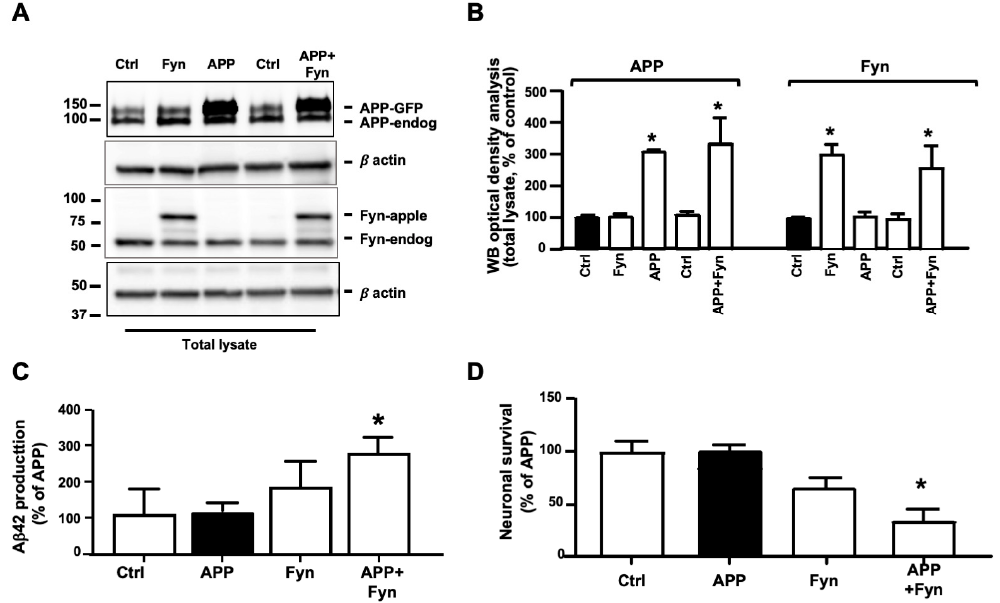
Figure 1. Amyloidogenic amyloid precursor protein (APP) processing increased in APP-GFP- and Fyn-apple-tagged neurons. ( A ) APP, Fyn, and β -actin Western blot (WB) analysis of neural stem cells after 48 h of transfection with APP-GFP (500 ng, APP) and Fyn-apple (500 ng, Fyn). A GFP empty vector was used as an internal loading control (Ctrl) or to balance the total amount of DNA for each experimental point (1 μ g DNA/well). Total lysate (20 μ g) from each sample was loaded on 4–20% Tris-Gly. The densitometric analysis of APP-GFP and Fyn-apple is reported in ( B ). Optical density values were normalized to β -actin and were expressed as a percentage of Ctrl (black bar). n = 3. * p < 0.05, vs. control using one-way ANOVA followed by Dunnett’s post hoc test. ( C ) ELISA analysis of A β 42 from media of Ctrl, APP-GFP, Fyn-apple, and APP-GFP+Fyn-apple transfected neurons. A β 42 levels were normalized to the number of alive cells (DAPI stained nuclei) that were present on each slide after 48 h of transfection and were expressed as ng of A β 42 that were released from each cell in 0.5 mL of media. Data are reported in ( C ) as % of APP transfected neurons. Each experiment was performed three times in triplicate ( n = 3). * p ≤ 0.05, vs. APP (black bar). Statistically significant differences were calculated using one-way ANOVA followed by Dunnett’s post hoc test. ( D ) Transfected neurons and GFP transfected controls were stained with DAPI, and the number of alive neurons was counted under an immunofluorescence microscope. Each experiment was performed three times in triplicate ( n = 3). The data are expressed as a percentage of APP. * p < 0.05, vs. APP (black bar). Statistically significant differences were calculated using one-way ANOVA followed by Dunnett’s post hoc test.